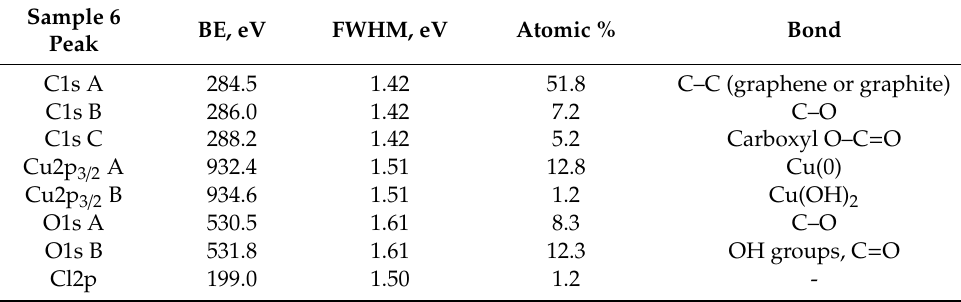
Table 3. Summary of XPS results for Sample 6 of graphene on Cu substrate [47].